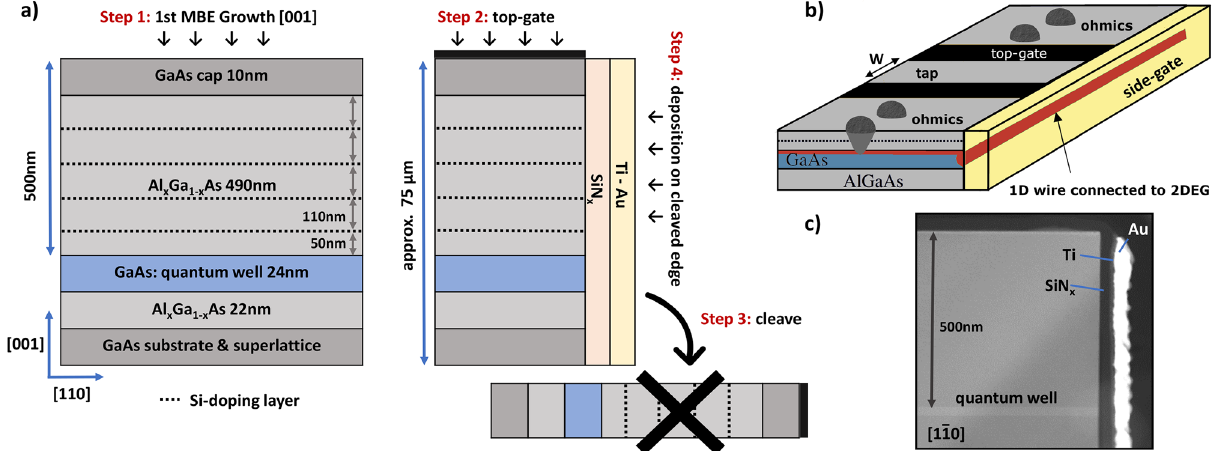
Figure 1. ( a ) Stepwise illustration of the novel cleaved edge deposition method. Step one consists of the first MBE growth along [001] direction resulting in a high mobility 2DEG buried 500 nm under the surface. In the second step top-gates are defined on the (001) surface and the substrate is thinned down to approximately 75 μm. In steps 3 and 4 the experimentally challenging 2nd overgrowth has been replaced by an ex-situ cleave and a side-gate deposition. ( b ) The 3D schematic illustrates the one-dimensional wire forming along the edge (highlighted in red) by applying positive side-gate voltages. By applying negative top-gate voltages the 2DEG underneath the top-gates can be depleted and the chemical potential in the 1D wires tuned. The wires are contacted over the 2DEG reservoirs to which they are coupled over the entire edge. ( c ) A HAADF TEM image of the side-gate deposition onto the cleaved